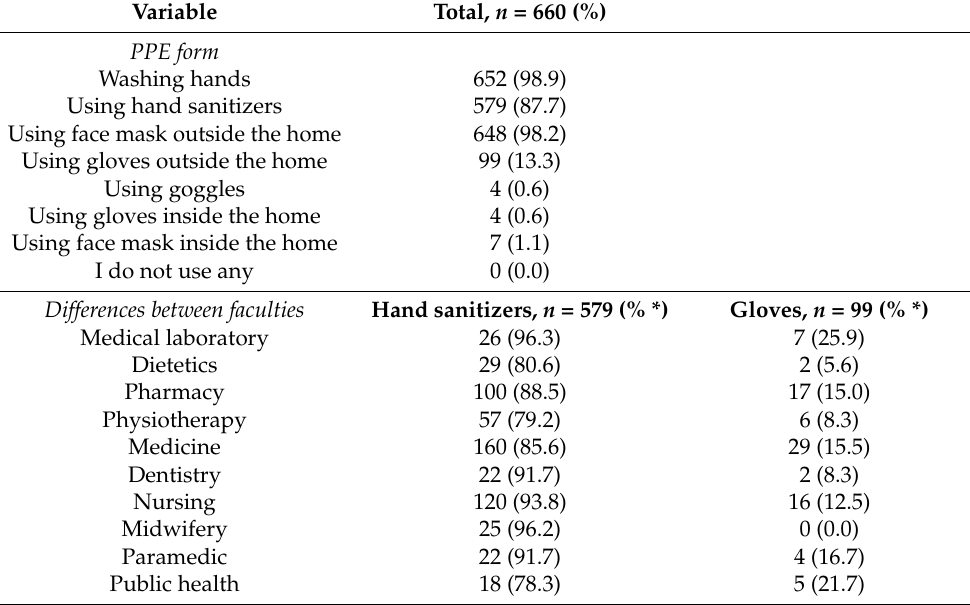
Table 4. Types of PPE used by study participants and differences in using hand sanitizers and gloves between